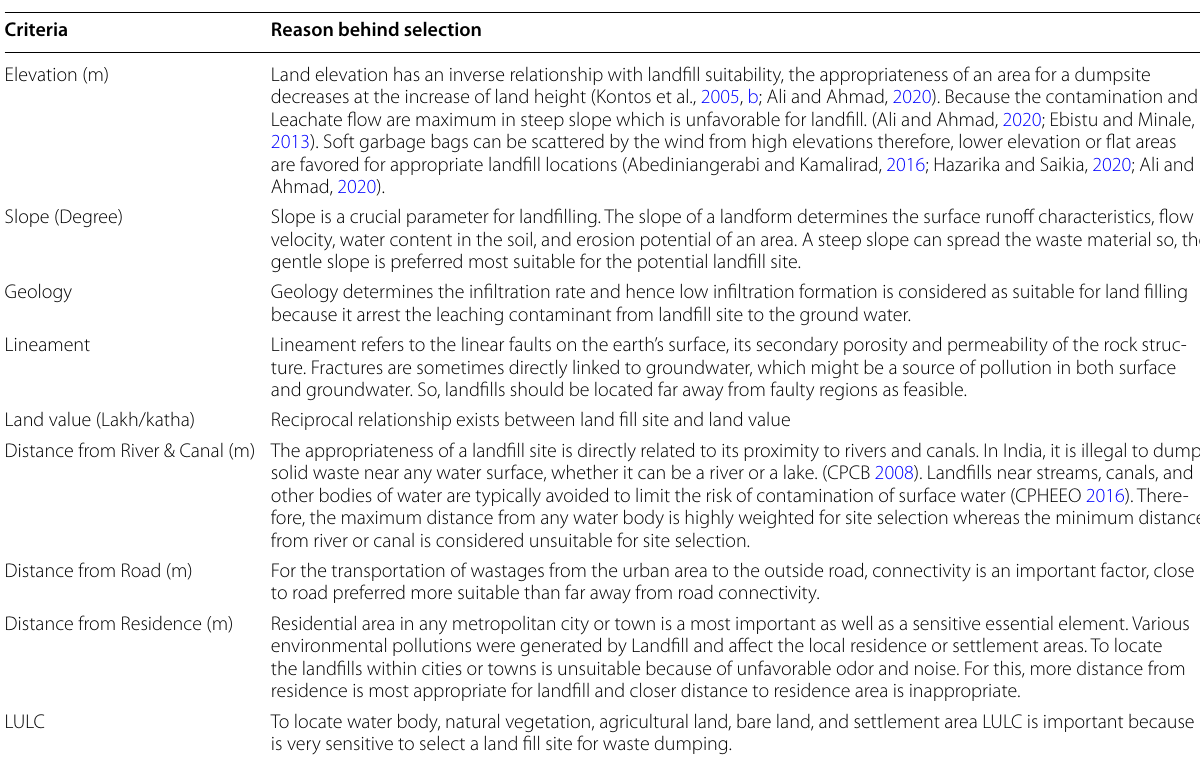
Table 2 landfill site selection criteria and reason behind their